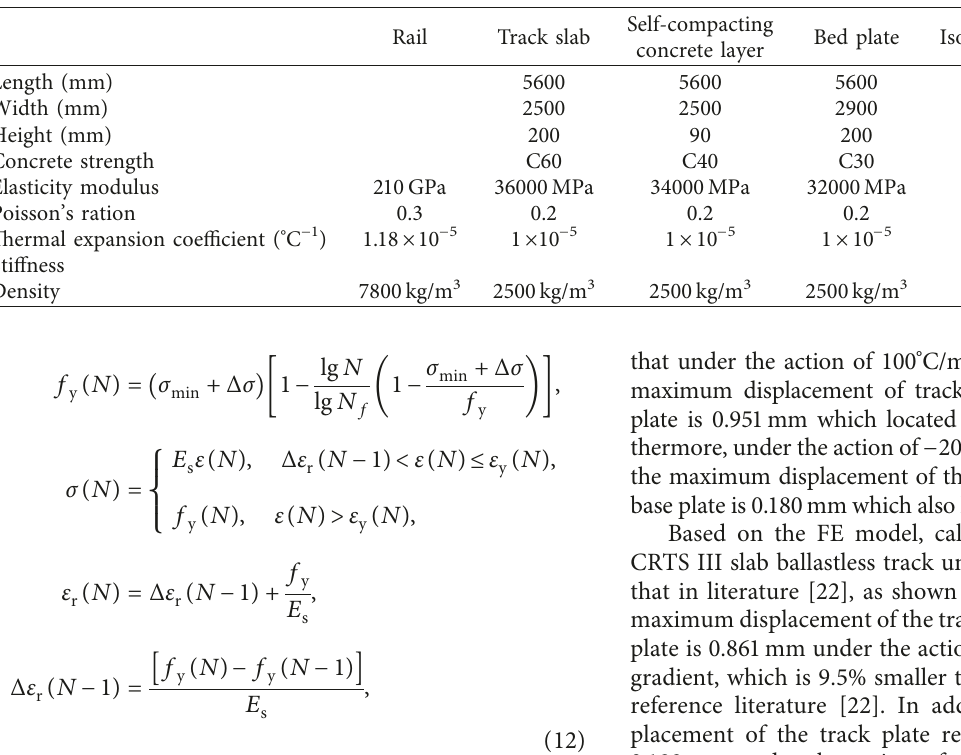
Table 5: The basic specifications of main